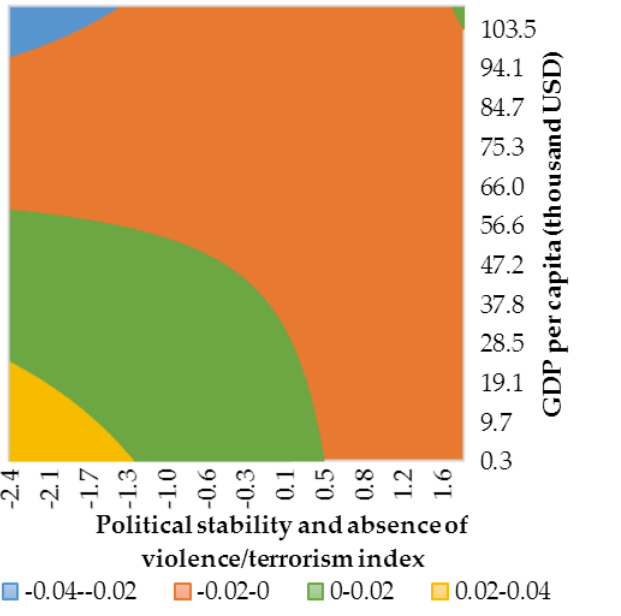
Figure A20. Conditional effect of financialisation on growth based on Est. 20 in Table A2. ( a ) Estimated conditional slope coefficient over the whole range of observed values for institutional quality and development level. ( b ) Estimated statistically significant conditional slope coefficient. Gray represents a combination of institutional quality and development level for which effect of financialisation on growth is statistically insignificant. Source: authors’ contributions.